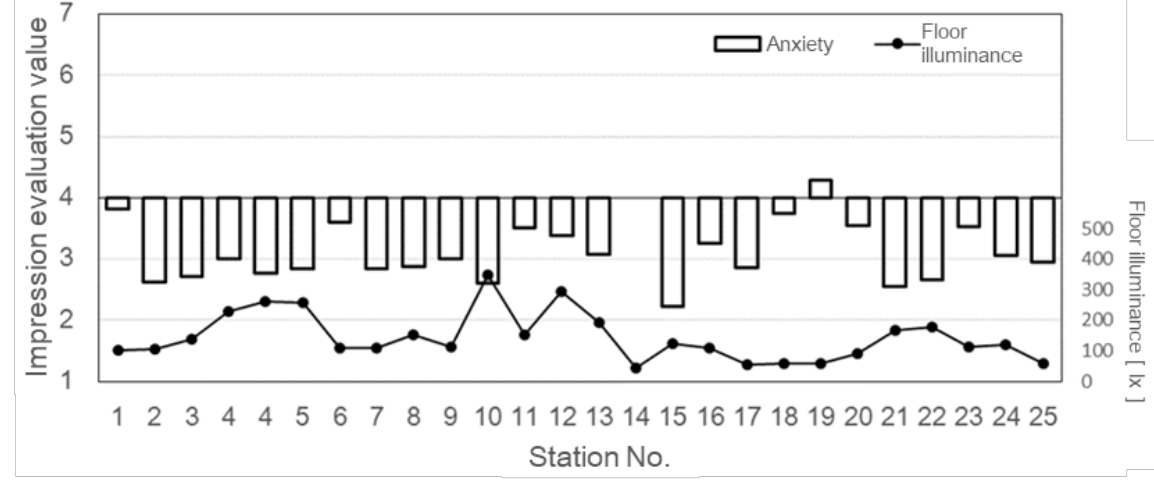
Figure 15. Results of the impression evaluation of anxiety and floor illuminance.